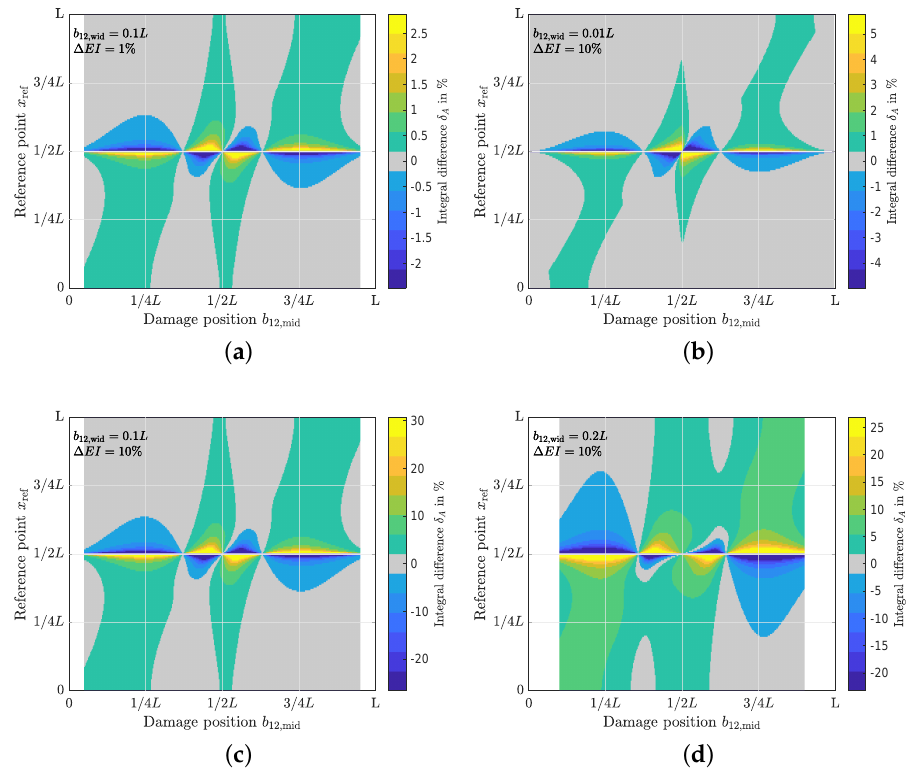
Figure 6. Contour plots for the relative integral difference of the displacement influence line η w . The relative integral difference is shown in colour. The damage location b 12,mid is plotted on the abscissa and the reference point x ref is plotted on the ordinate. ( a ) b 12,mid = 0.1 L and ∆ EI = 0.01; ( b ) b 12,mid = 0.01 L and ∆ EI = 0.1. ( c ) b 12,mid = 0.1 L and ∆ EI = 0.1. ( d ) b 12,mid = 0.2 L and ∆ EI =